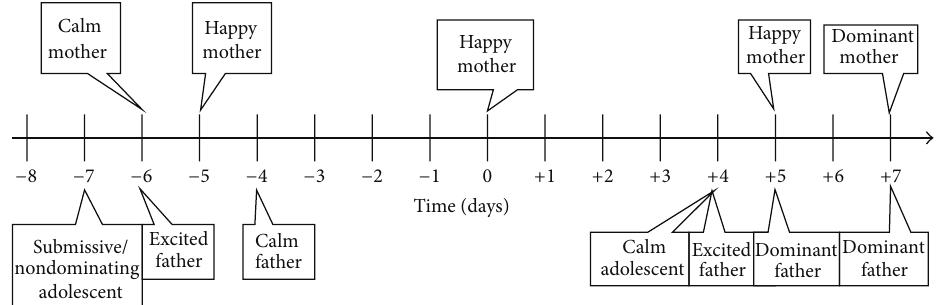
Figure 4: Timeline displaying effects correlating with affective valence in the mother of the adolescent index patient. The graph depicts a psychosomatic cycle in which various emotional states of all involved family members influence affective valence (pleasure) of the mother to the adolescent patient and vice